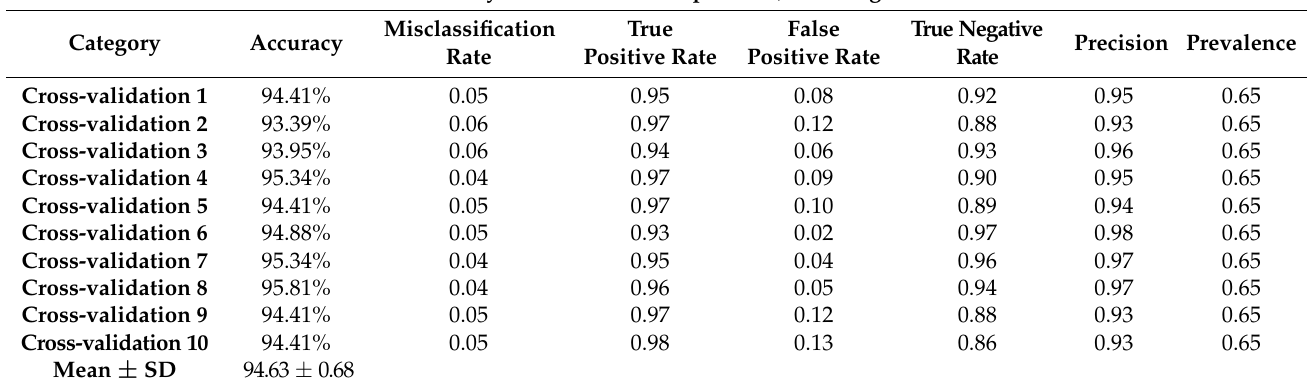
Table 2. Misclassification rate, accuracy, false positive rate, true negative rate, true positive rate, prevalence, precision, standard deviation of accuracy, and